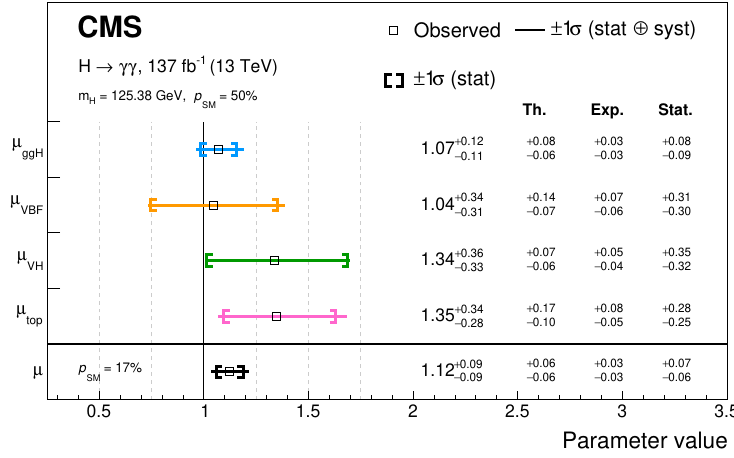
Figure 16 . Observed results of the fit to signal strength modifiers of the four principal production modes. The contributions to the total uncertainty in each parameter from the theoretical systematic, experimental systematic, and statistical components are shown. The colour scheme is chosen to match the diagram presented in figure 1. The compatibility of this fit with respect to the SM prediction, expressed as a p -value, is approximately 50%. Also shown in black is the result of the fit to the inclusive signal strength modifier, which has a p -value of 17%.